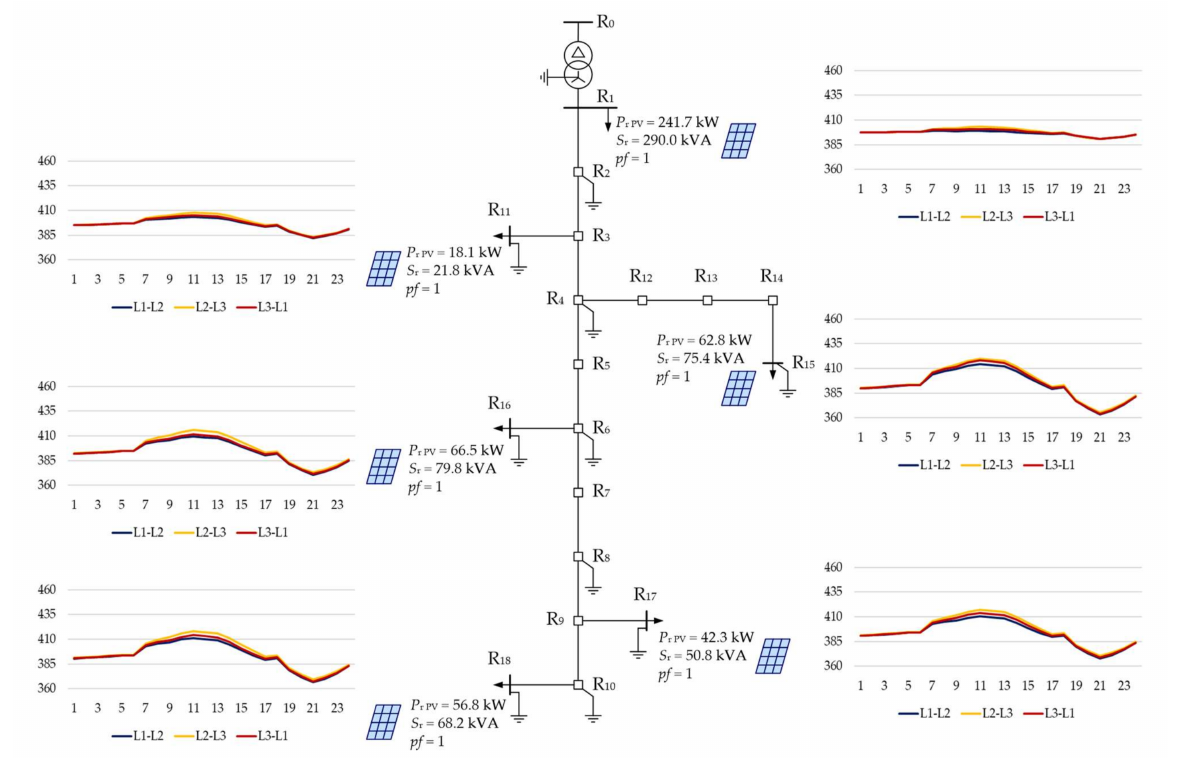
Figure A1. Daily simulation results for variant V4: phase-to-phase voltages (V).